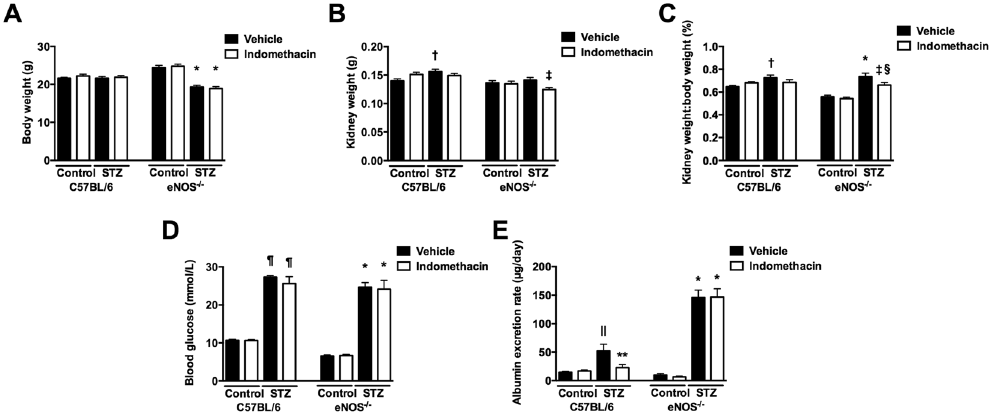
Figure 2. Effect of treatment with indomethacin for two weeks in non-diabetic and streptozotocin (STZ)- diabetic wildtype (C57BL/6) and eNOS knockout (eNOS − / − ) mice (n = 10/group). ( A ) Body weight. ( B ) Kidney weight. ( C ) Kidney weight:body weight ratio. ( D ) Blood glucose. ( E ) Urine albumin excretion. * p < 0.0001 vs. eNOS − / − + vehicle or eNOS − / − + indomethacin; † p < 0.01 vs. C57BL/6 + vehicle; ‡ p < 0.05 vs. STZ-eNOS − / − + vehicle; § p < 0.01 vs. eNOS − / − + vehicle or eNOS − / − + indomethacin; ¶ p < 0.0001 vs. C57BL/6 + vehicle or C57BL/6 + indomethacin; || p < 0.001 vs. C57BL/6 + vehicle or C57BL/6 + indomethacin; ** p < 0.01 vs. STZ-C57BL/6 +